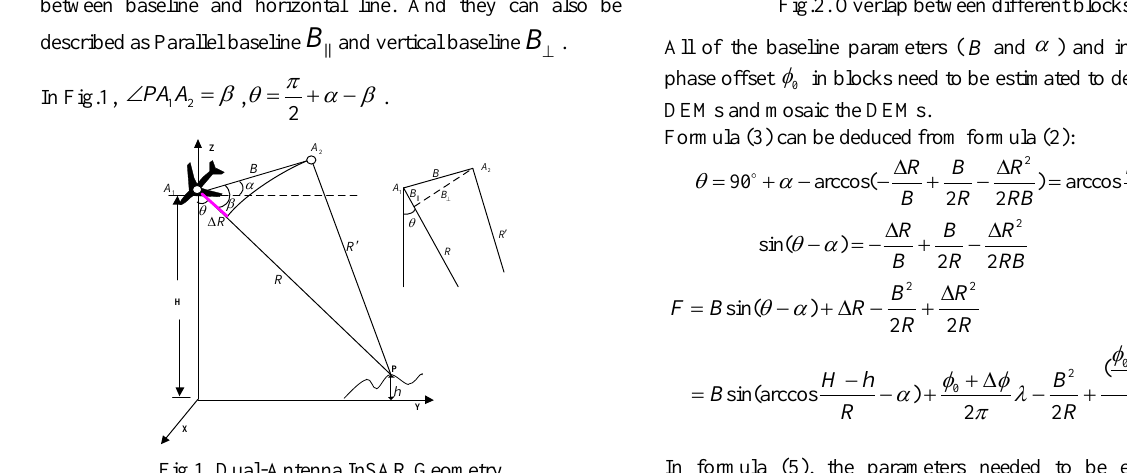
Fig.1. Dual-Antenna InSAR Geometry